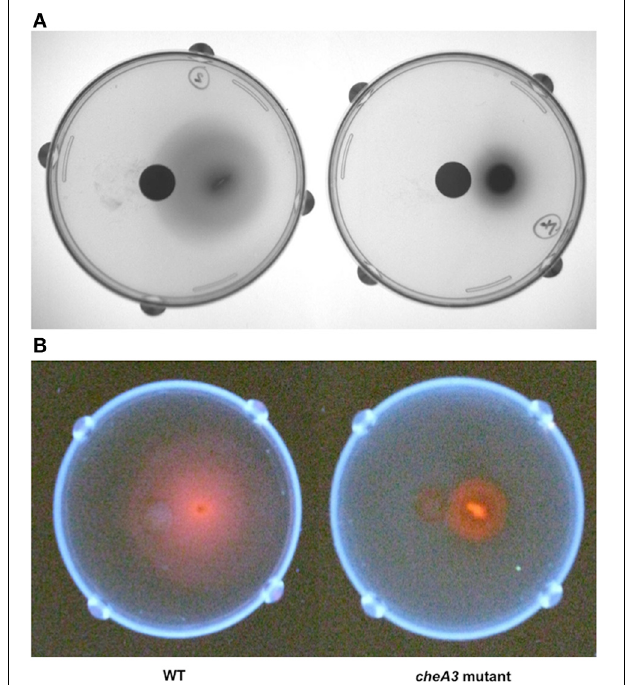
FIGURE 4 | Soft agar plate disc assays of D. vulgaris wild type and cheA3 mutant strains with a nylon membrane disc soaked in 30mM sulfate. Modified LS4D medium contained 0.4% (wt/vol) agar, 12mM sodium sulfate, and 60mM sodium lactate. Pictures were taken with